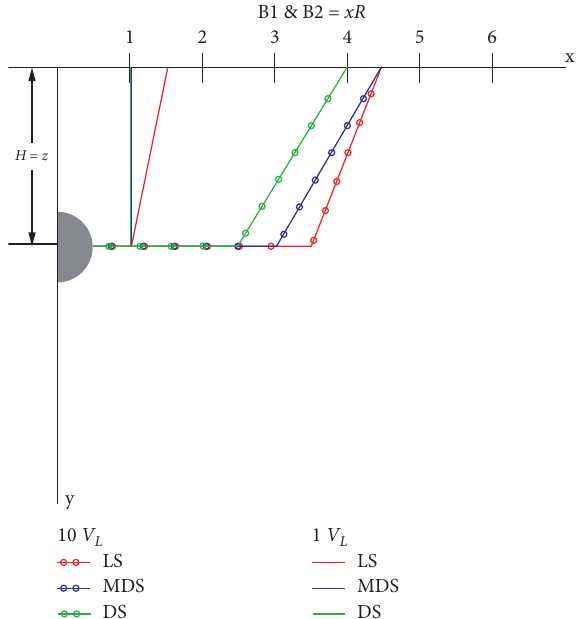
Figure 12: Influence zones for large tunnel ( D � 9m). B1 and B2 are top and bottom width of influence zone measured in terms of tunnel radius “R .” “H ” is the height of influence zones in terms of tunnel diameter “ D